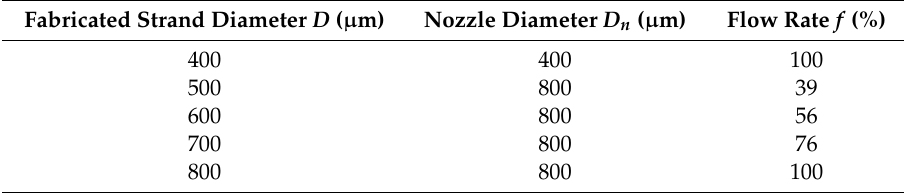
Table 2. Values of the flow rate f utilized to obtain di ff erent strand